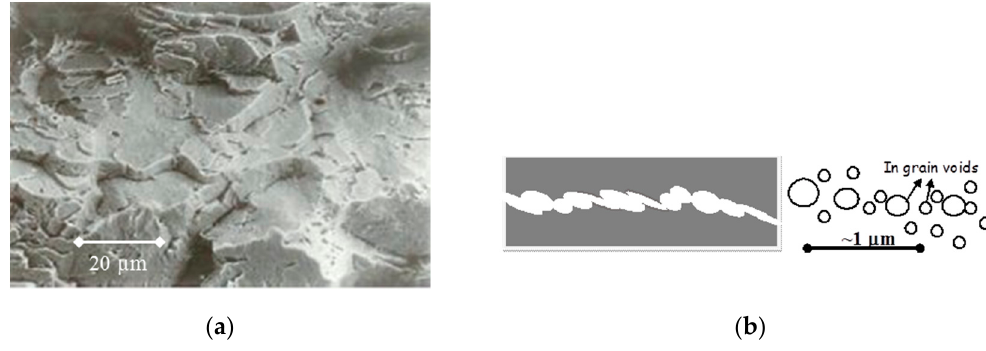
Figure 11. Example of channel fracture of: ( a ) 20%CW A316 irradiated at 385 °C to ~64 dpa in EBR-II and tensile tested by 6 × 10 − 4 s − 1 at 205 °C. Adapted and modified according [31] with courtesy of F. A. Garner. The material exhibited ~3–8% of void swelling. Courtesy of F. A. Garner [31]; ( b ) Scheme of the TG channel fracture owing shear of bridges linking up the voids according to the TEM image in [33].